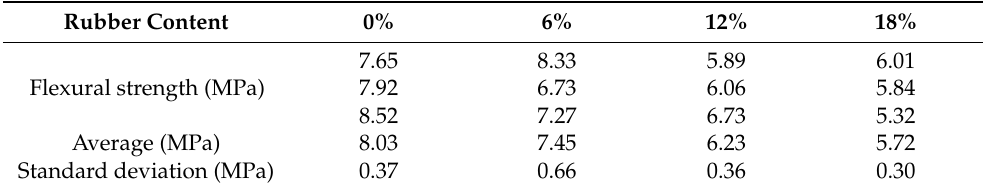
Table 10. Test results of flexural